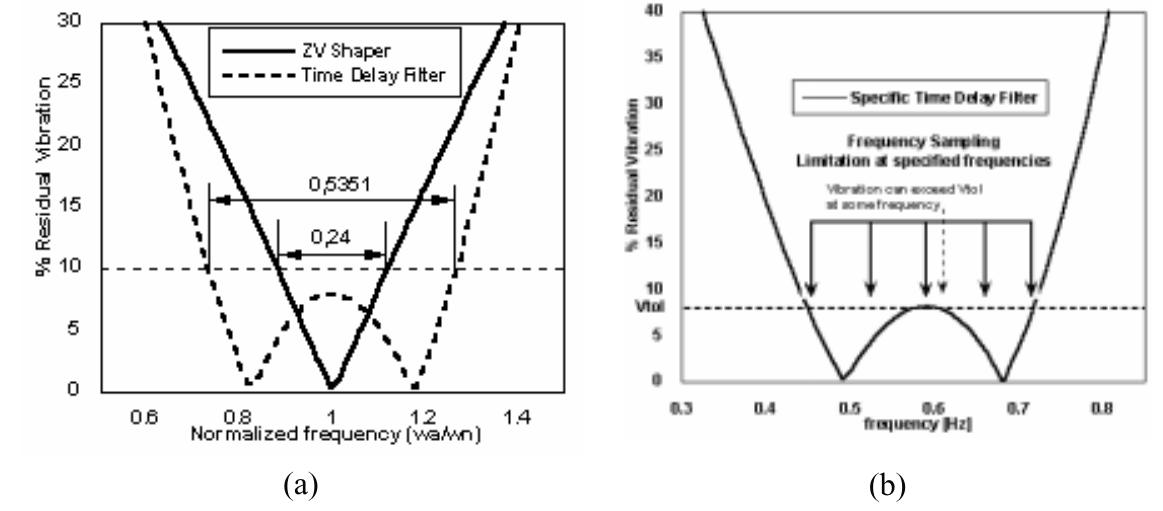
Fig. 4. (a) ZV shaper and Time Delay Filter sensitivity curves. (b) Specified Time Delay Filter synthesized by the frequency sampling method.